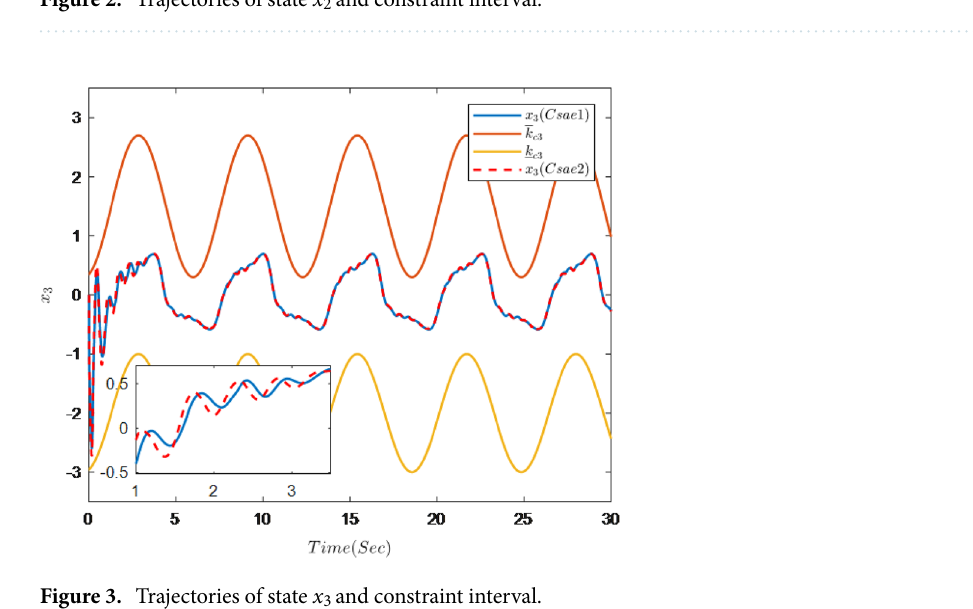
Figure 2. Trajectories of state x 2 and constraint interval.